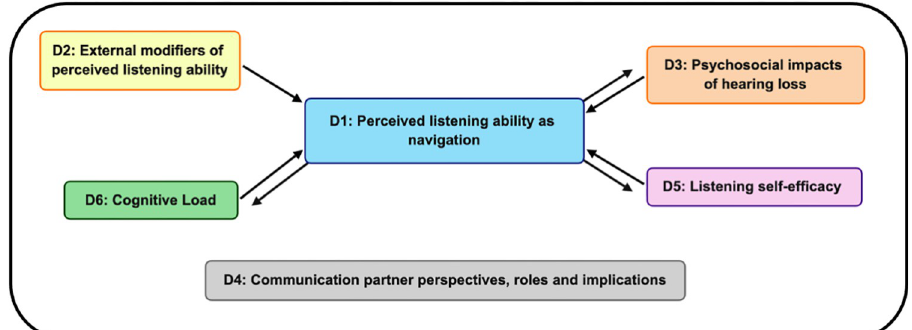
Fig 2. Hypothetical model of relationships among the descriptive